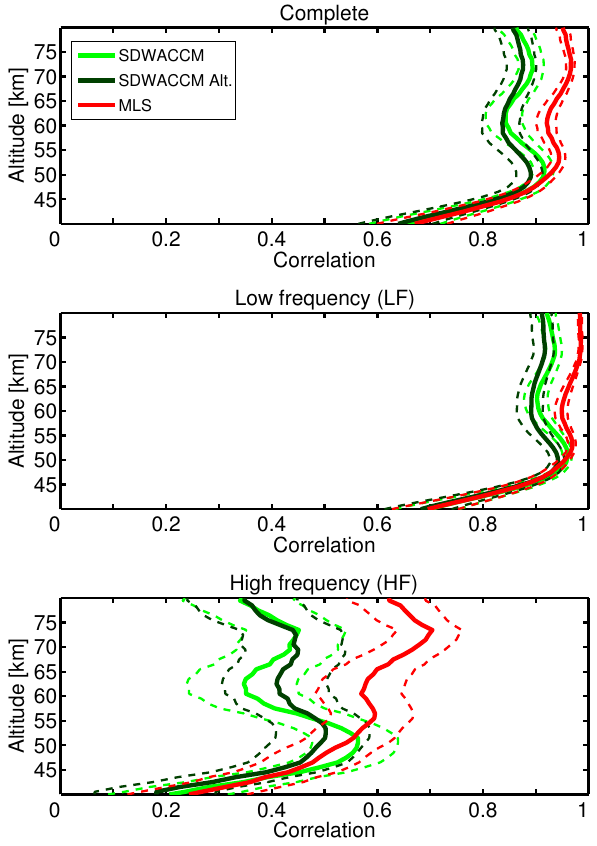
Fig. 8. Altitude profiles of the correlation coefficients as in Fig. 6, but for the alternative KIMRA-SDWACCM comparison, which is based on a crossover point that is lower (between 40 and 50km) than for all other SD-WACCM data shown in this paper. The orig- inal correlations for KIMRA-SDWACCM and KIMRA-MLS are shown here only for comparison and are the same as in Fig. 6. The dashed lines indicate the 95% confidence interval of the correlation